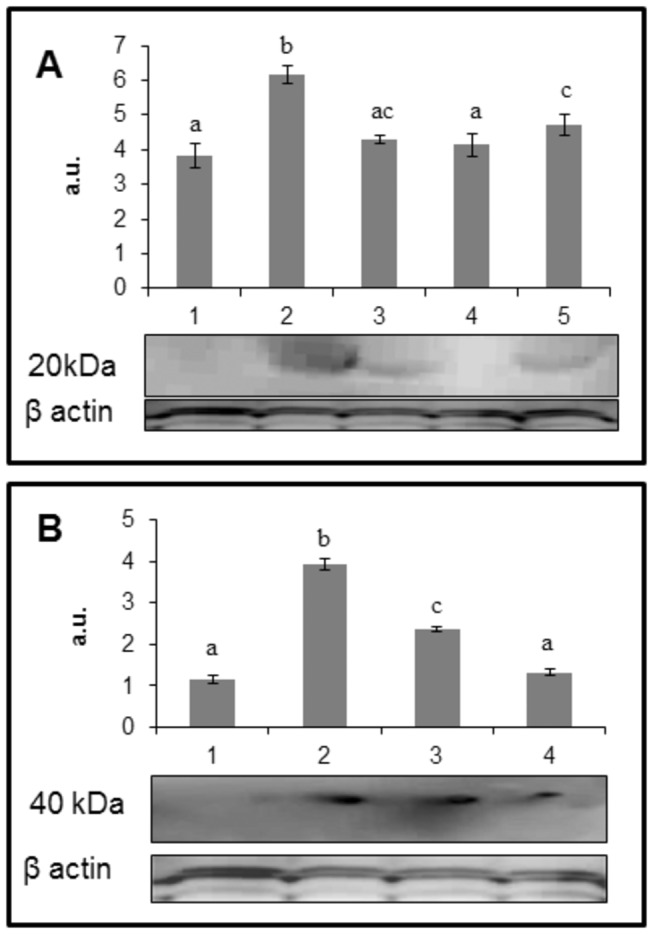
Immunodetection of advanced glycation endproducts, CML (Panel A) and AGE-BSA (Panel B), in the soluble protein fraction of rat lens.The data in bar diagram are mean ± SD (n=3) and the blot is a representative of three independent analyses. Lane 1: control; lane 2: diabetic (D); lane 3: D + curcumin; lane 4: D + nanocurcumin and lane 5: D + blank particles. Different superscripts indicate data are significantly different from other groups.